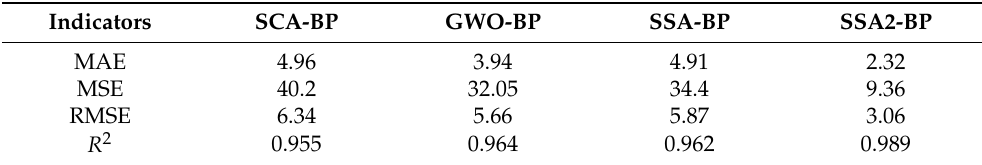
Table 7. Prediction error